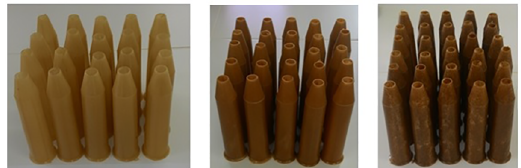
Figure 3. Photos of tubes (a) PHB, (b) PHB/Wood flour (80/20) and (c) PHB/Sisal fiber